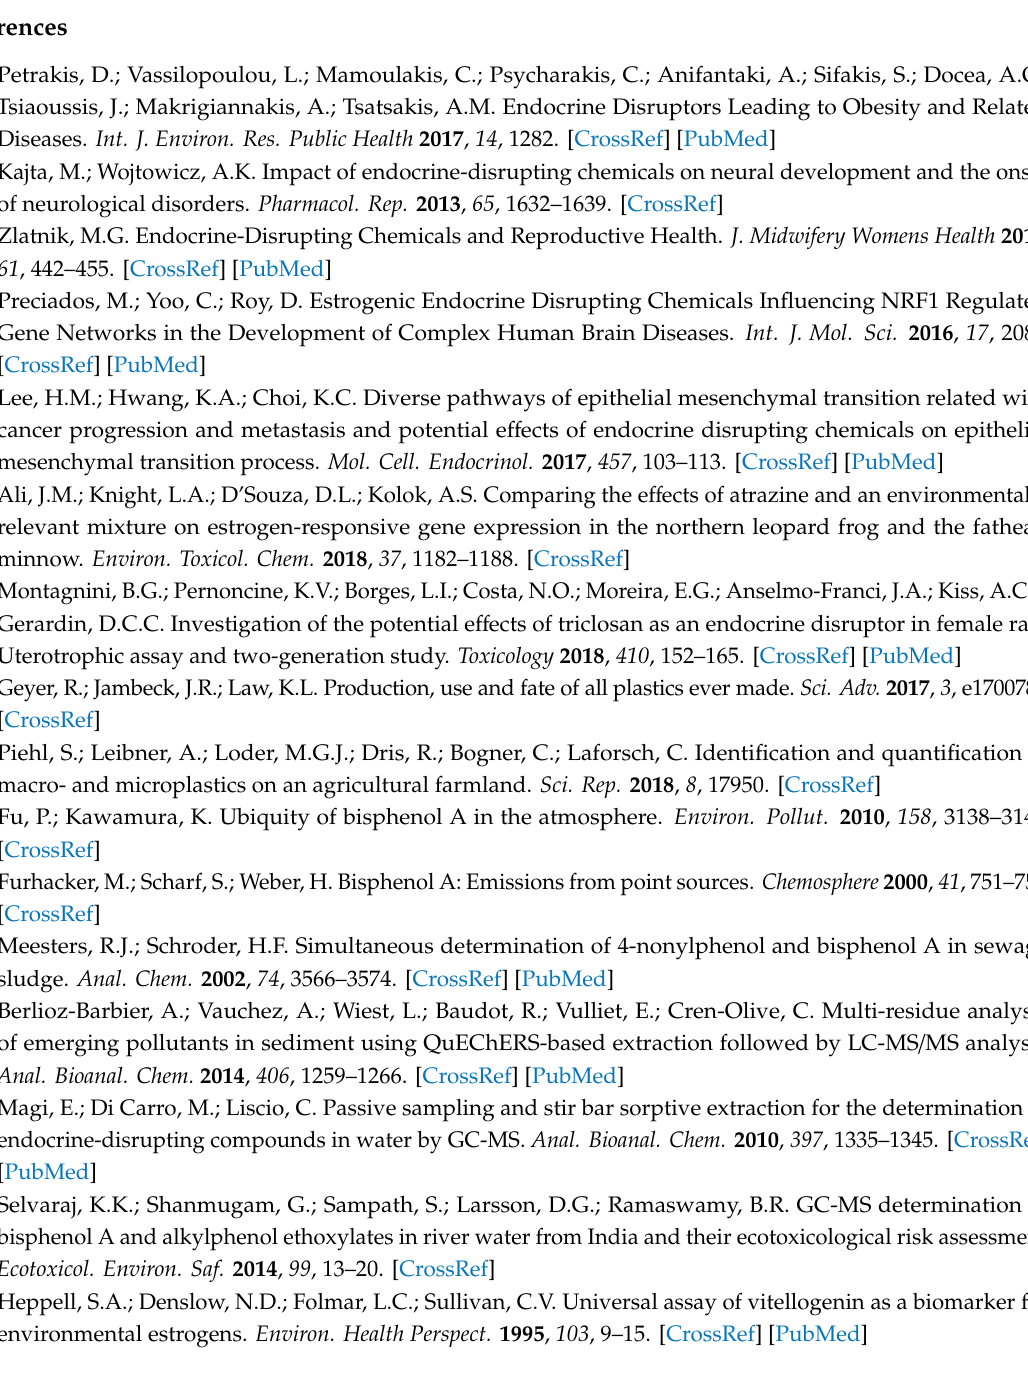
Table S1: List of the primer sequences used in this